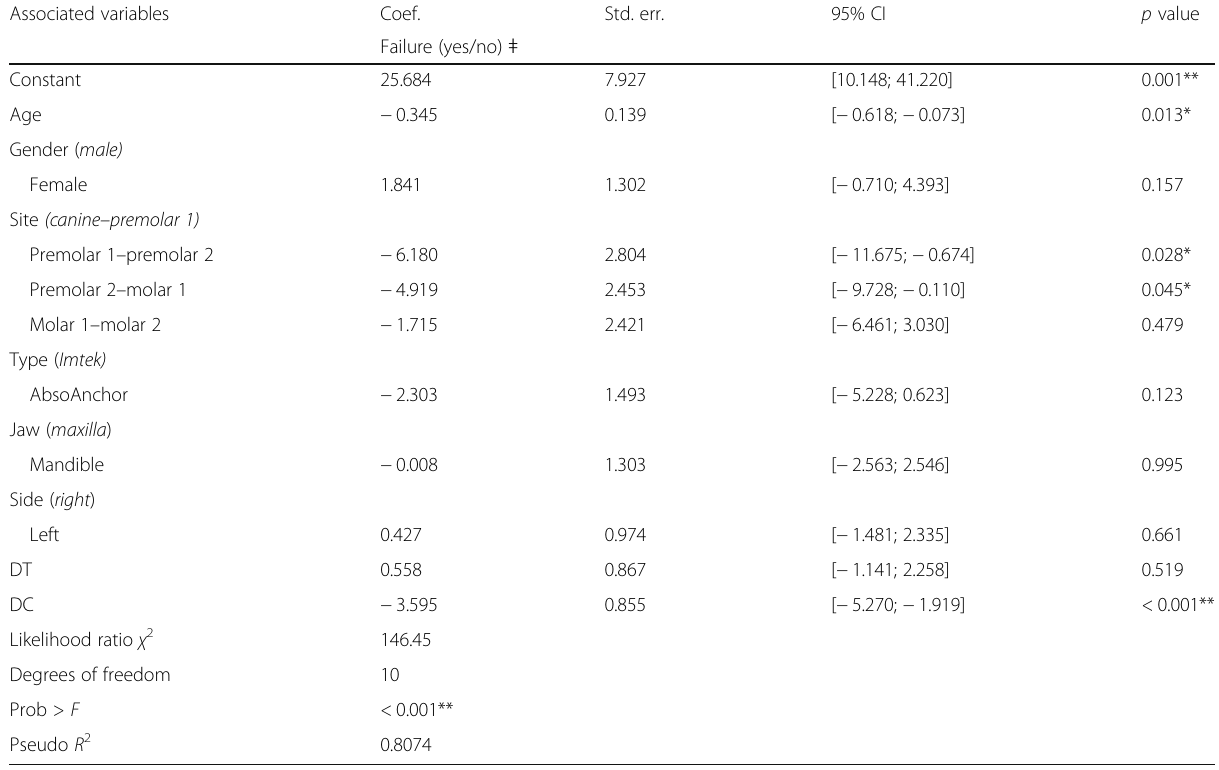
Table 4 Multivariate logistic analysis showing associations between mini-implant success and explanatory variables ( n = 260) Associated variables Coef. Std.